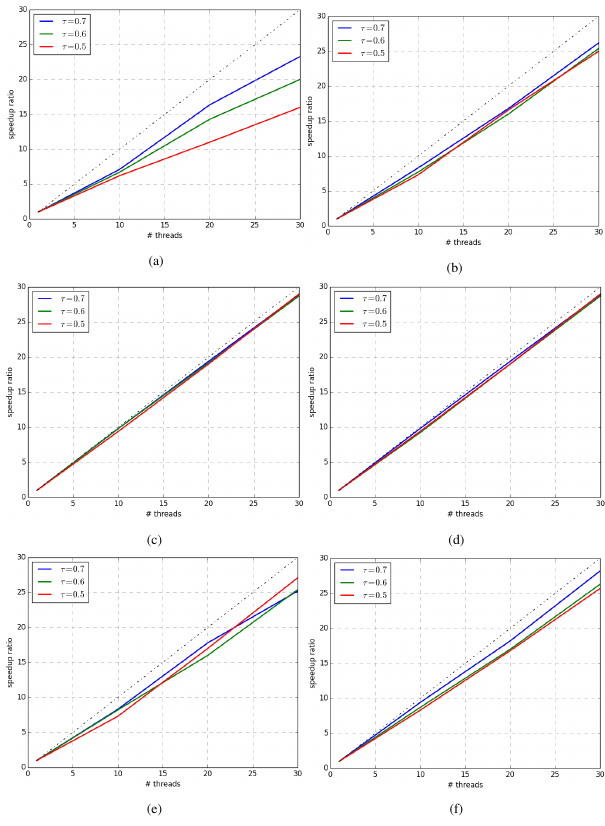
Fig. 7: Performance of the parallel algorithms running on a single SMP bullx node of 30 compute cores. The Figure 5. Performance of the parallel algorithms – (a) clustering speedupratioscorrespondtotheanalysisofthenetworks1-3presentedinTable1. coefficient, (b) entropy, (c) degree centrality, (d) strength central- ity, (e) eigenvector centrality and (f) betweenness centrality. Algo- rithms are run on a single SMP bullx node of 30 compute cores. The speedup ratios correspond to the analysis of the networks 1–3 presented in Table 1.